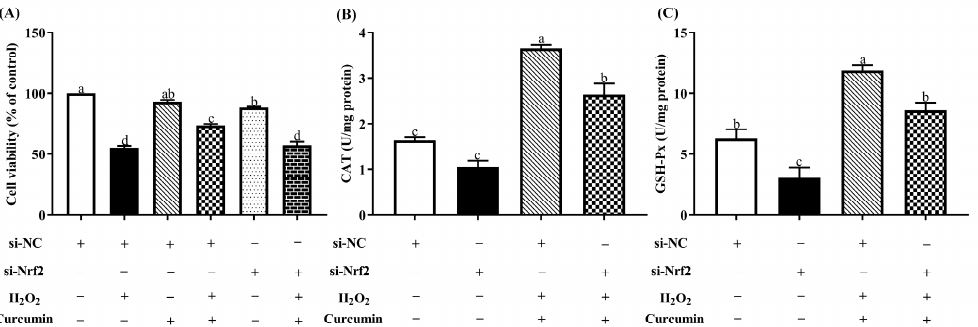
Figure 8. Silencing Nrf2 gene abolished the prevention made by curcumin. HTR8/SVneo cells transfected with siRNA against Nrf2 or control siRNA for 24 hours, followed by 24 h pre-treatment with 5 µ M curcumin, and then treated with 400 µ M H 2 O 2 for another 24 h. The cell viability ( A ), CAT ( B ) and GSH-Px ( C ) activity of cells were determined respectively. Data are presented as the mean ± SEM (n=3). a, b, c, d Means with different letters are significantly different ( p < 0.05).